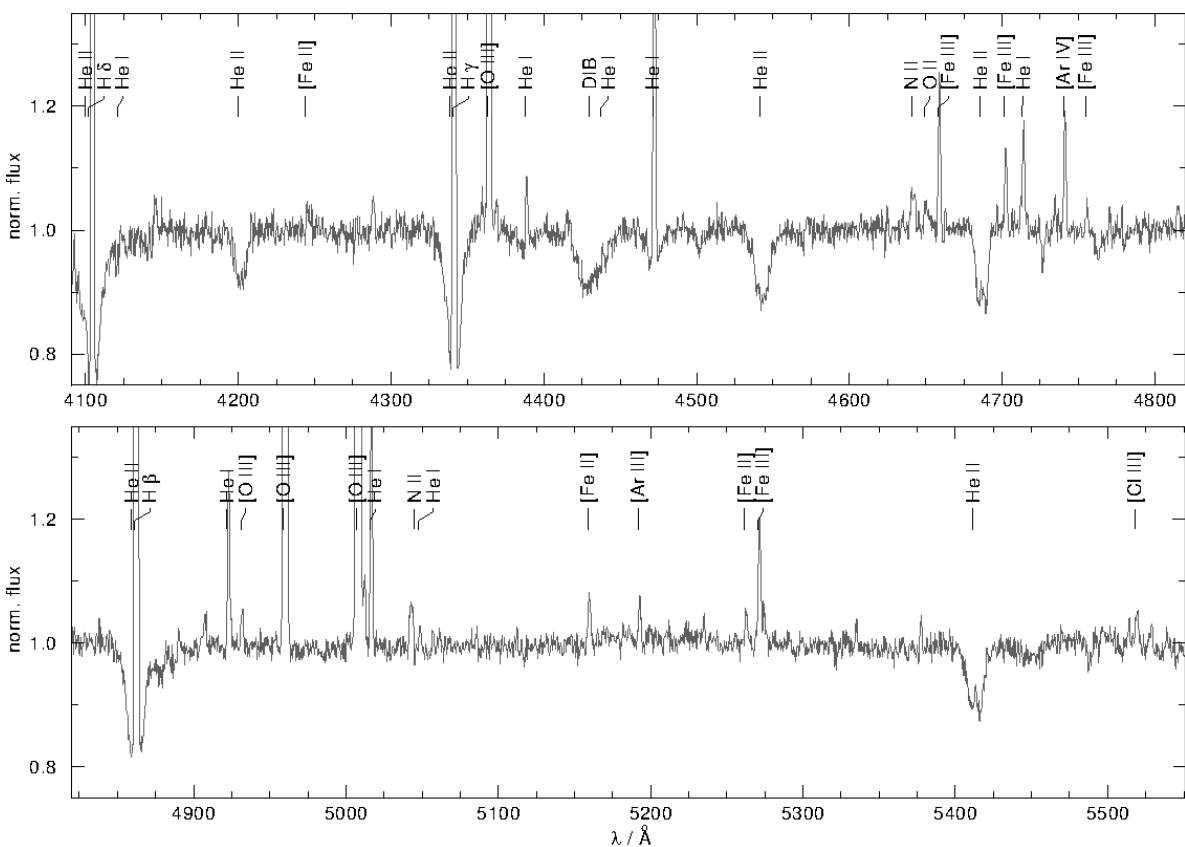
Figure 1. FORS2 spectrum of Hen2-428. Identified lines are